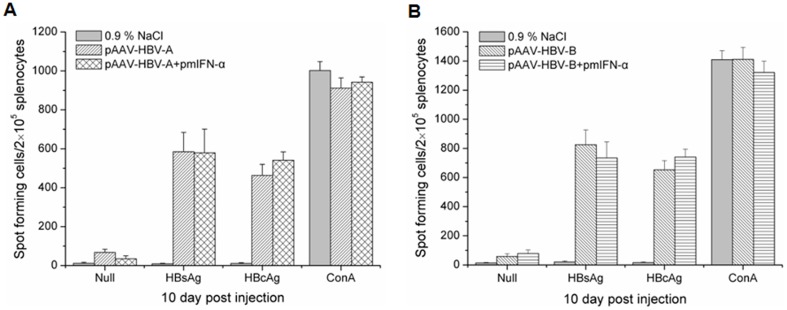
Detection of T-cell responses to HBsAg and HBcAg in mice received HI with HBV clones and pmIFN-α.The specific T-cell responses to the full length HBsAg and HBcAg in mice were analyzed by ELISPOT assays after HI with HBV clones and pmIFN-α. The numbers of HBsAg and HBcAg specific IFNγ secreting cells in 2×105 splenocytes of the mice HI with pAAV-HBV-A and pmIFN-α (A) or HI with pAAV-HBV-B and pmIFN-α (B) at 10 d by IFNγ ELISPOT assay in the presence of 0.5 µg/ml full length HBsAg or HBcAg peptide. 5 µg/ml of ConA was used as positive control and 0.5 µg/ml of CMV was used as negative control (data not shown). The experiments were done in duplicate and spleen specimens of at least three mice per group were analyzed (n≥3). The data were analyzed by t test but no significant difference between the experimental groups was found (p>0.05).